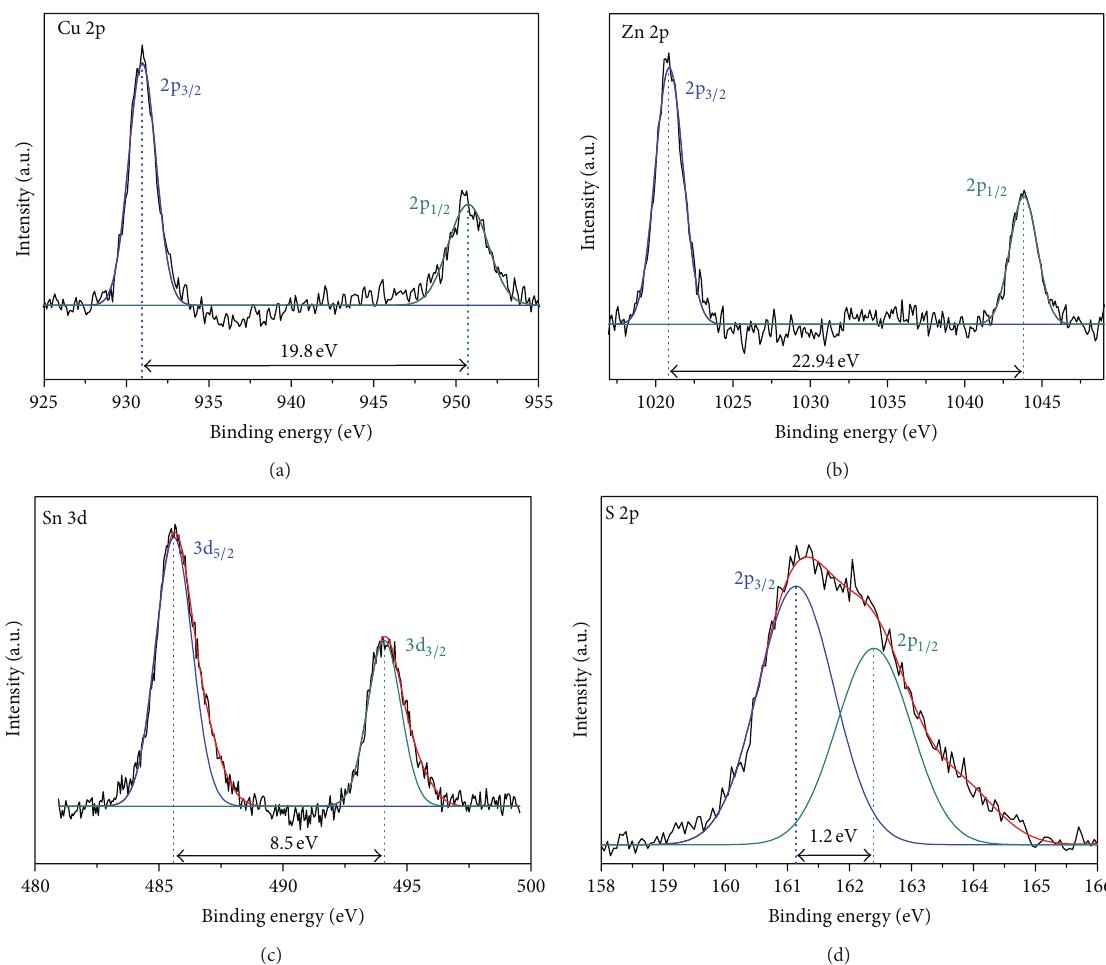
Figure 6: The high-resolution XPS spectra measured for CZTS film (a) Cu 2p, (b) Zn 2p, (c) Sn 3d, and (d) S 2p core levels, respectively.